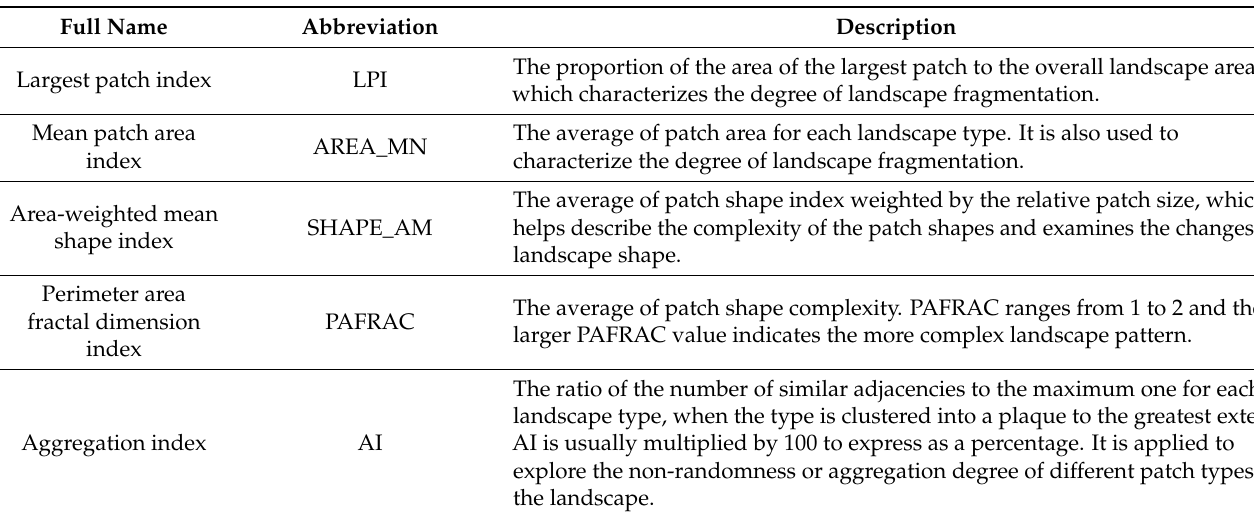
Table 3. Description of the landscape metrics applied to explore the crane habitat